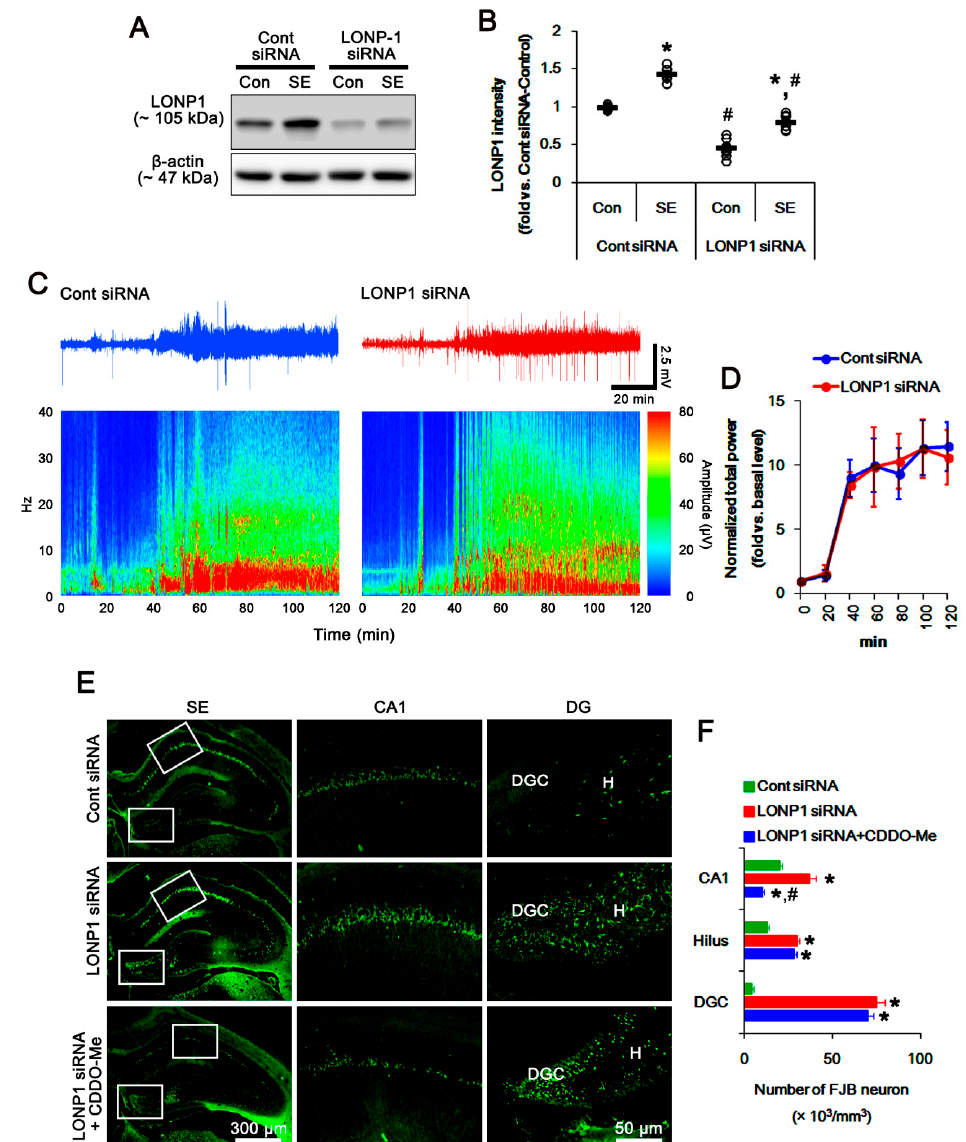
Figure 7. Effects of LONP1 siRNA on LONP1 expression, seizure activity and neuronal damage in response to pilocarpine. ( A , B ) Effect of LONP1 knockdown on LONP1 expression in response to pilocarpine. LONP1 siRNA effectively reduced LONP1 expression under physiological- and post-SE conditions. ( A ) Representative western blots of LONP1 expression. ( B ) Quantification of LONP1 expression based on western blot data. Open circles indicate each individual value. Horizontal bars indicate mean value (mean ± S.E.M.; *p < 0.05 vs. control animals, respectively; n = 7). ( C , D ) Effect of LONP1 knockdown on seizure activity in response to pilocarpine. LONP1 siRNA does not influence seizure activity induced by pilocarpine. ( C ) Representative EEG traces and frequency-power spectral temporal maps in response to pilocarpine. ( D ) Quantification of total EEG power (seizure intensity) in response to pilocarpine. Open circles indicate each individual value. Horizontal bars indicate mean value (mean ± S.E.M.; n = 7, respectively). ( E , F ) Effects of LONP1 siRNA and co-treatment of CDDO-Me on neuronal death induced by pilocarpine. LONP1 knockdown deteriorates degenerations of CA1 neurons, hilus interneurons ( H ) and dentate granule cells (DGC). Co-treatment of CDDO-Me attenuated CA1 neuronal death induced by SE. ( E ) Representative photos of FJB positive degenerating neurons. ( F ) Quantification of the number of FJB positive neurons in response to pilocarpine (mean ± S.E.M.; * ,# p < 0.05 vs. control siRNA and LONP1 siRNA, respectively; n = 7,